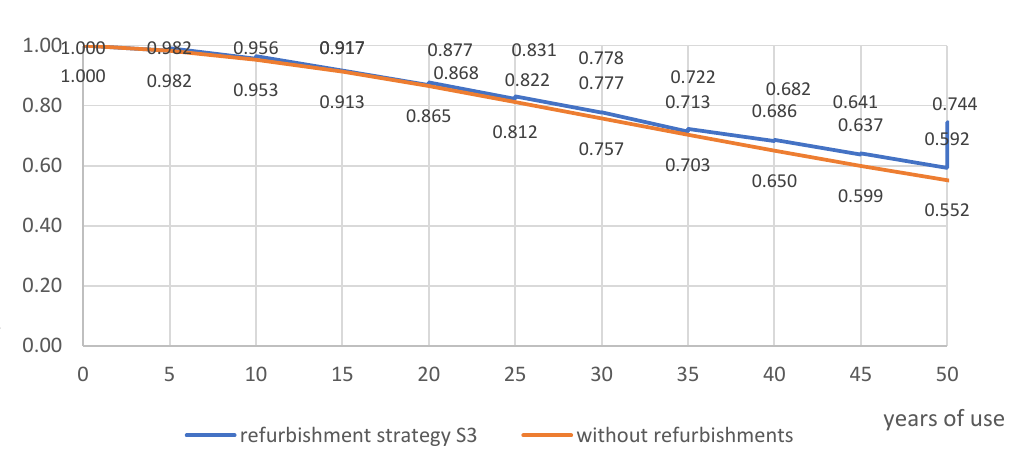
Figure 3. Prediction of changes in technical condition of a building refurbished according to S3 strategy and a building without refurbishment.